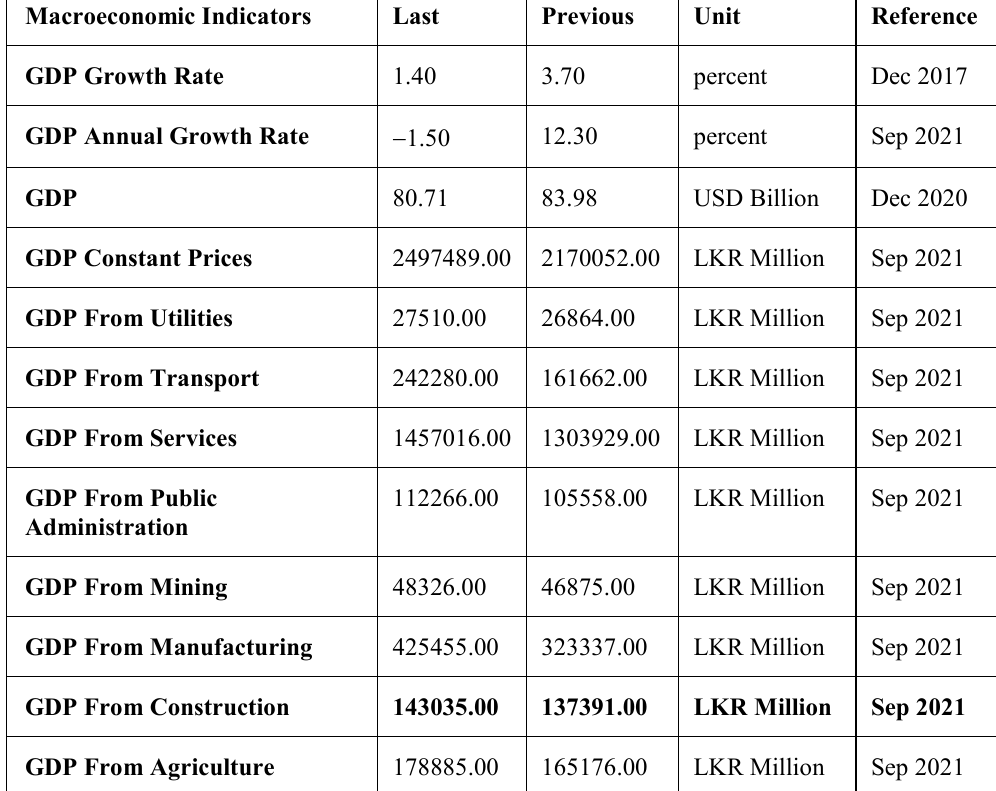
Table 2. Macroeconomic Indicators in Sri Lanka (Trading Economics, 2022) Macroeconomic